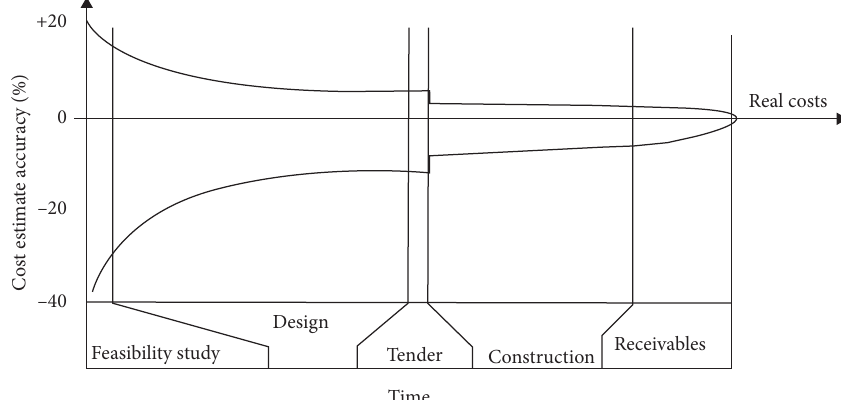
Figure 1: Cost estimate reliability